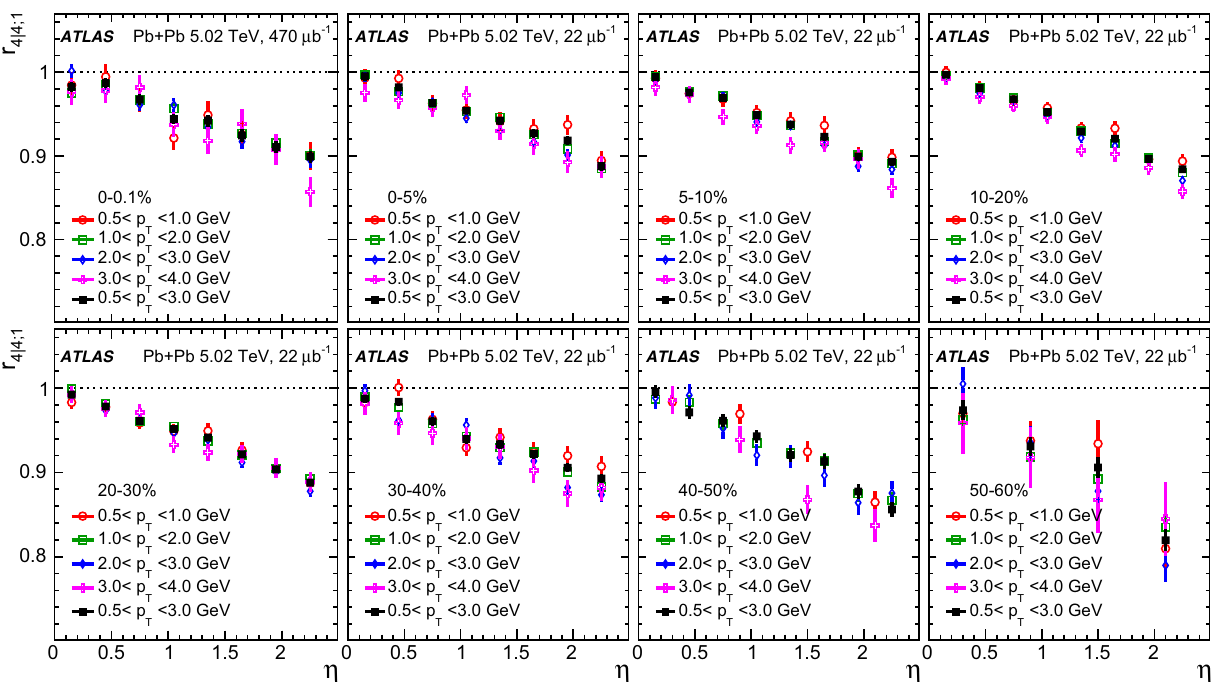
Fig. 28 The r 4 | 4 ; 1 (η) measured in several p T ranges for Pb+Pb collisions at 5.02 TeV. Each panel shows the results for one centrality range. The error bars are statistical only. The data points in some centrality intervals are rebinned to reduce the uncertainty Fig. 29 The r n | n ; 1 (η) (left panel) and R n | n ; 2 (η) (right panel) in ultra-central Pb+Pb collisions at 5.02 TeV. The error bars and shaded boxes are statistical and systematic uncertainties,